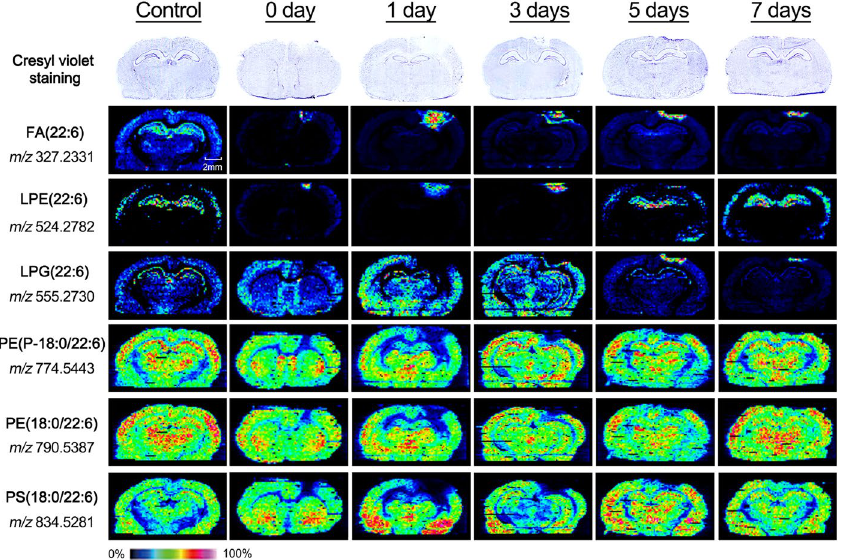
Figure 4. MSI of FA(22:6), LPE(22:6), LPG(22:6), PE(P-18:0/22:6), PE(18:0/22:6), and PS(18:0/22:6) in normal and TBI groups sacrificed at 0, 1, 3, 5, and 7 days after injury. Cresyl violet staining of brain sections was shown in above of the ion images.